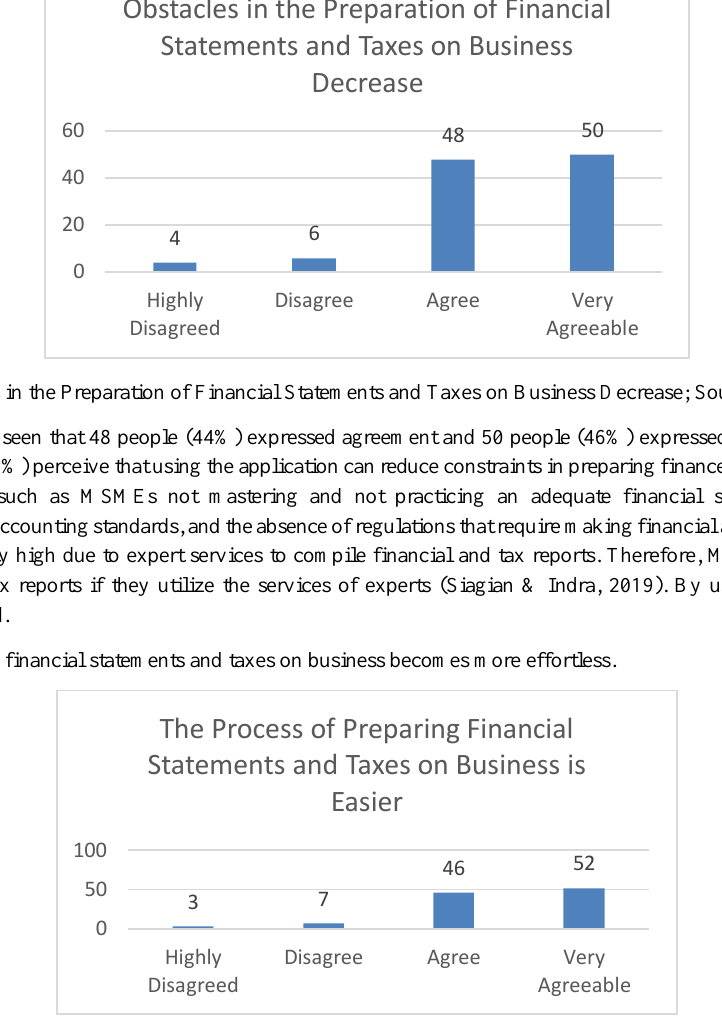
Figure 6: The Process of Preparing Financial Statements and Taxes on Business is Easier; Source: Own elaboration